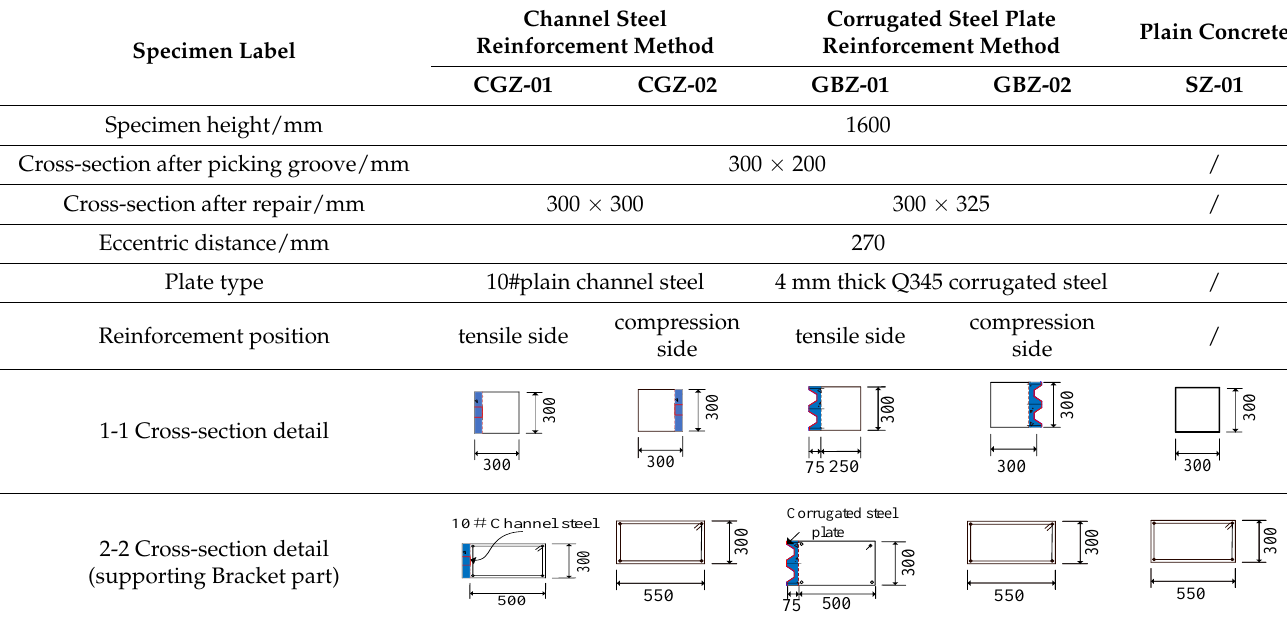
Table 1. Specimen design specification table.